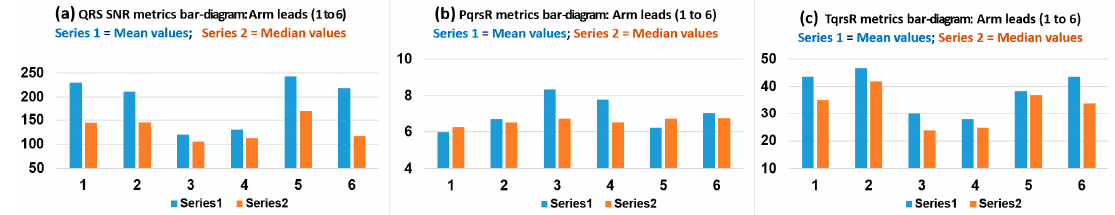
Figure 4. Bar charts presentation with amplified scale ranges (zoom-in) to facilitate depicting performance differentiation between the six arm leads mean and median value results (on the 30 subject cases) in Table 3: ( a ) for QRS SNR metric values, ( b ) for PqrsR (%) metric values and ( c ) for TqrsR (%) metric values.